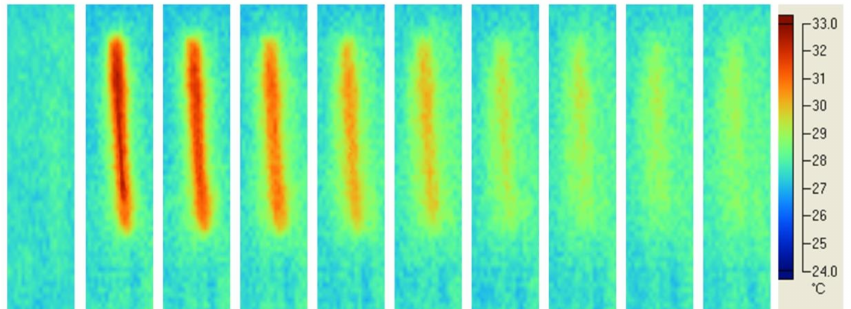
Figure 6. Light curing of CLM composite: typical temperature profiles using Mode II and laser line-shaped beam. The almost uniform distribution of temperature along the whole length of the specimen suggested a uniform polymerisation. Photograms were taken every 4 s.